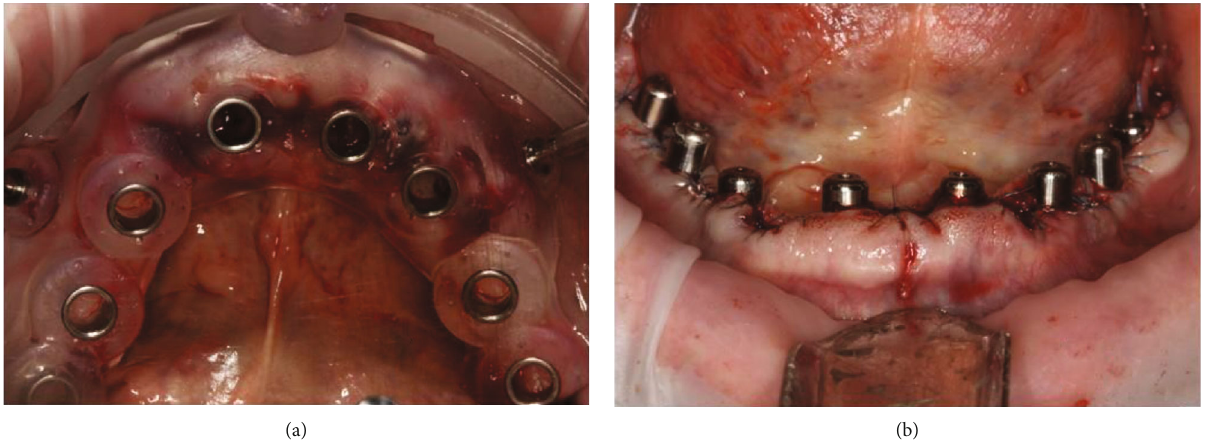
Figure 5: Full-guided surgical template attaching to the mandible (a). The condition of the jaw after placement of 8 dental implants by using standard protocol